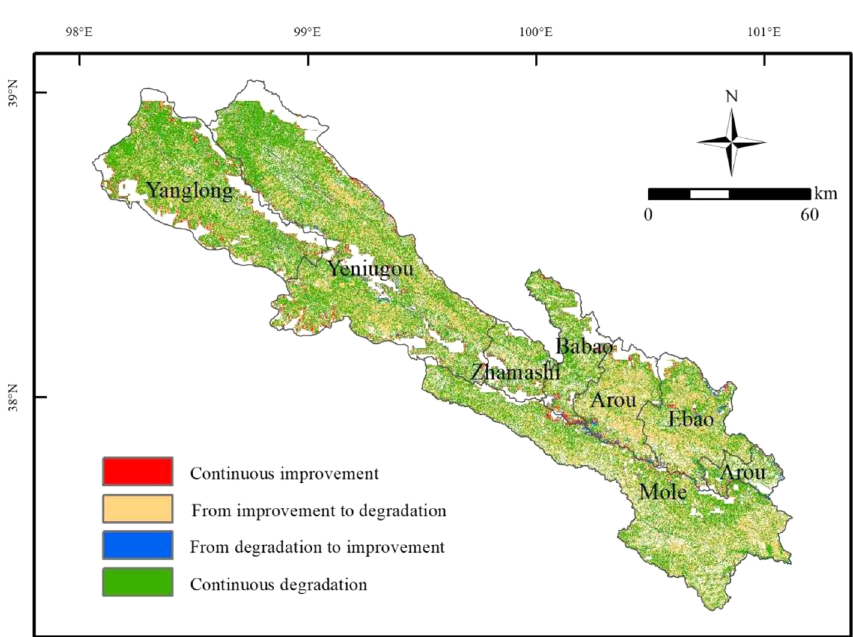
Figure 7. Spatial distribution of the forecasted grassland dynamic. The map was generated by ArcGIS 10.2, URL: https:// www. esri.